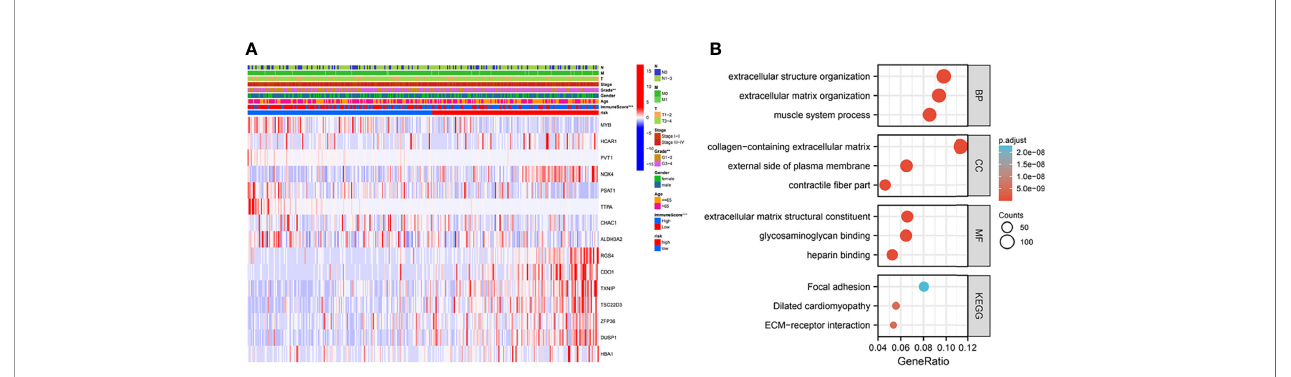
FIGURE 4 | Clinically relevant heat map and GO/KEGG pathway enrichment analysis. (A) Based on risk characteristics associated with prognosis, a heat map using data about clinicopathological characteristics of patients was plotted. The higher the intensity of red, the higher the expression. The higher the intensity of blue, the lower the expression. **p < 0.01, ***p < 0.001. (B) The graph shows the GO and KEGG analysis of high and low risk differential genes.